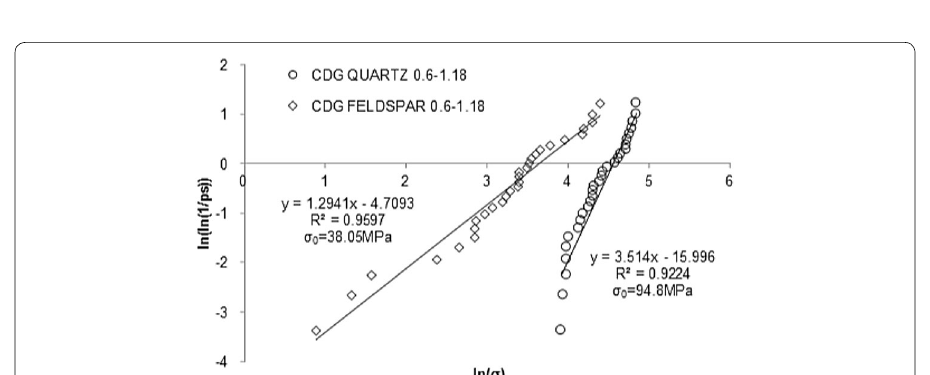
Fig. 5 The 37% survival possibility strength of CDG